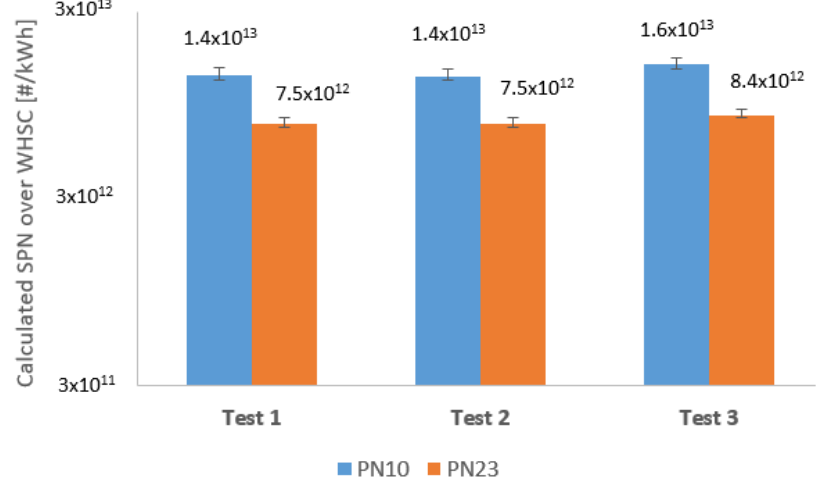
Figure 7. Transient particle concentration over 1st ( a ); 2nd ( c ); 3rd ( e ) WHSC cycle; Proportion of variance between <10 nm and <23 nm results over 1st ( b ); 2nd ( d ); 3rd ( f ) WHSC cycle. APC = AVL Particle Counter; CPC = Condensation Particle Counter; SPN = Solid Particle Number.